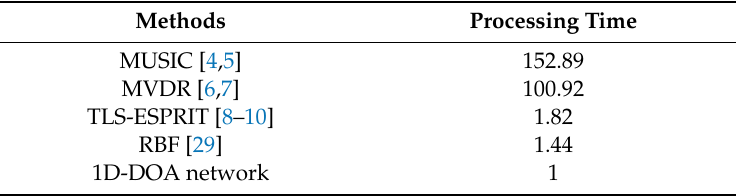
Table 3. Comparison of methods in processing time.